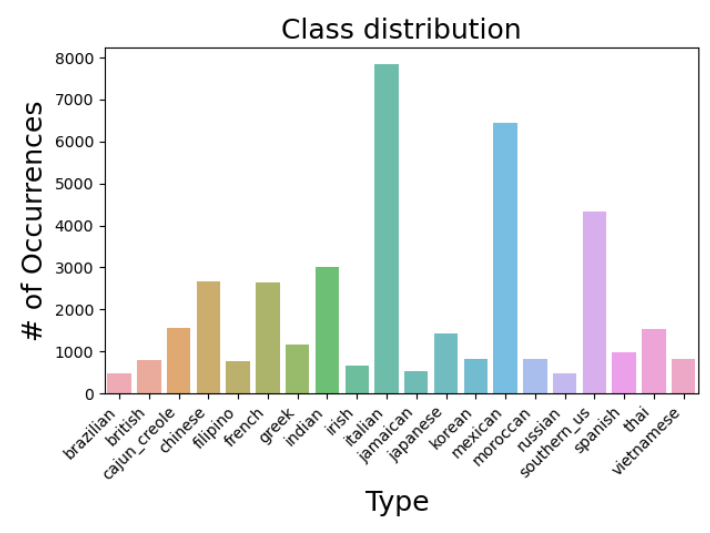
Figure 1. Class distribution for the Kaggle recipe train set.